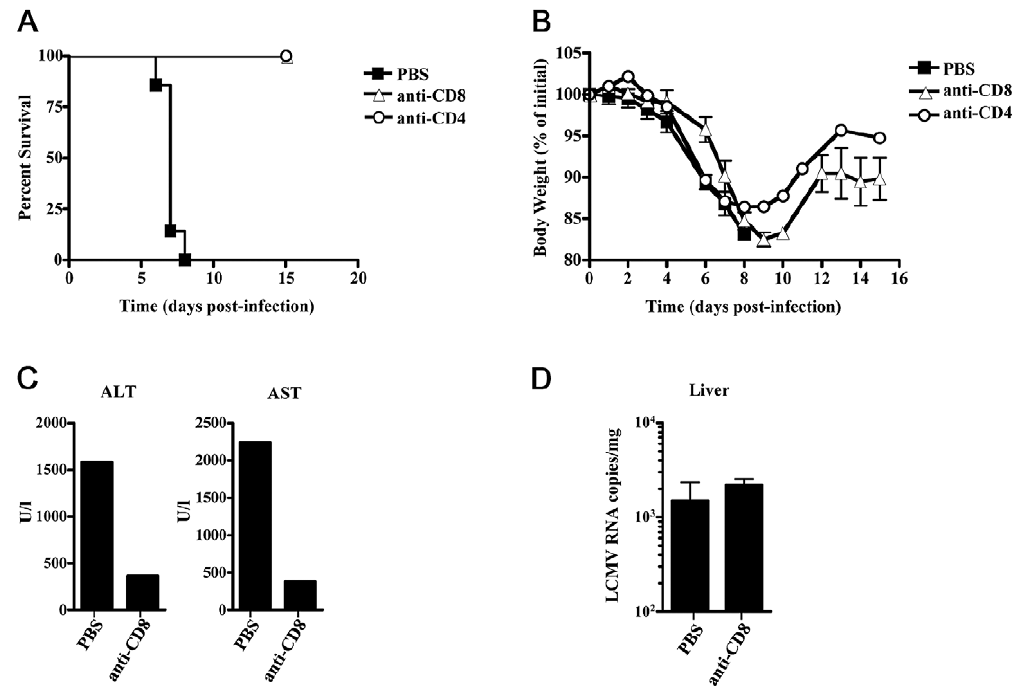
Figure 7. CD4 or CD8 depletion provides FVB mice protection from LCMV-13 induced death. FVB mice were treated with anti-CD8 antibody (n=3), anti-CD4 antibody (n=3) or PBS (n=3) at days 0 and 1 post-infection with 1 6 10 6 p.f.u. LCMV-13. Survival (A) and weight (B) were monitored daily until day 17 post-infection. Animals were humanely killed upon development of severe disease. C) Serum from 3 mice was combined and analyzed for AST and ALT levels. D) Viral burden in tissues measured after sacrificing animals. Levels of infectious virus in indicated tissue at time of death were quantitated by qRT-PCR for LCMV RNA. Results are presented as mean + / 2 standard deviation. Results are representative of two independent experiments.